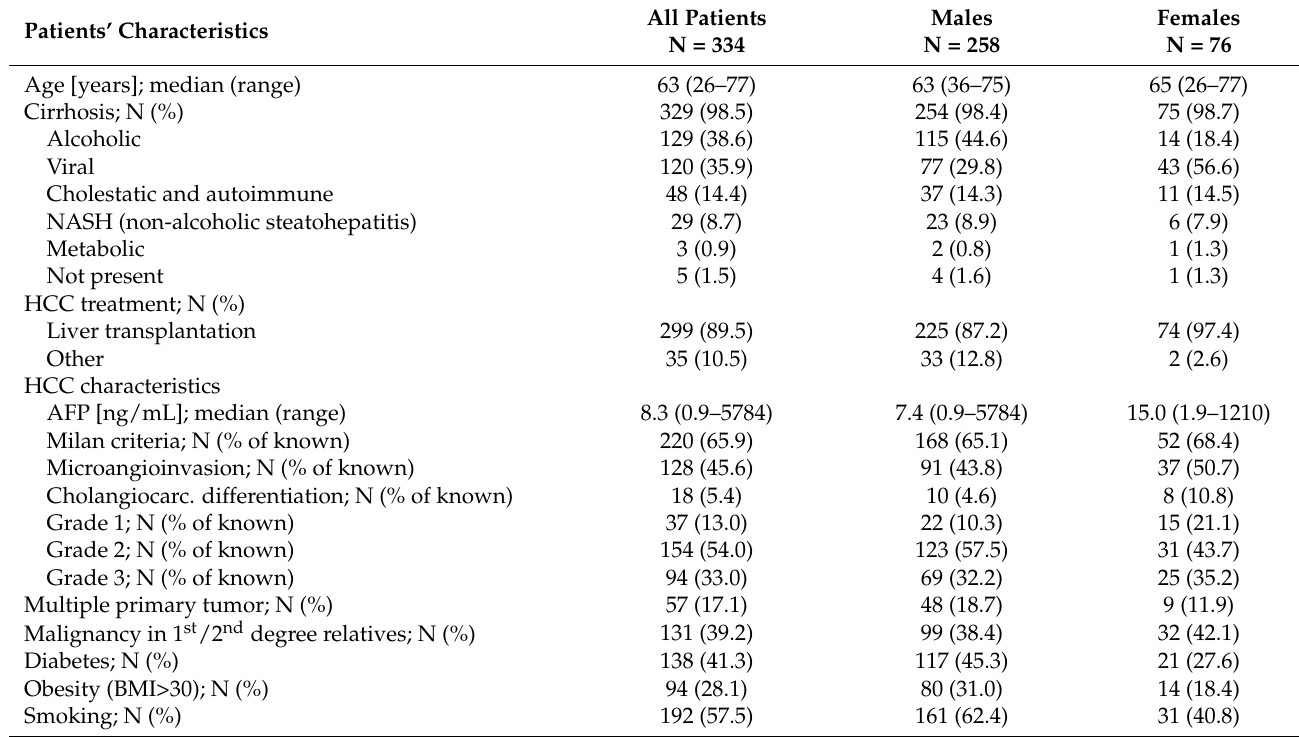
Table 1. Clinicopathological characteristics in all 334 HCC